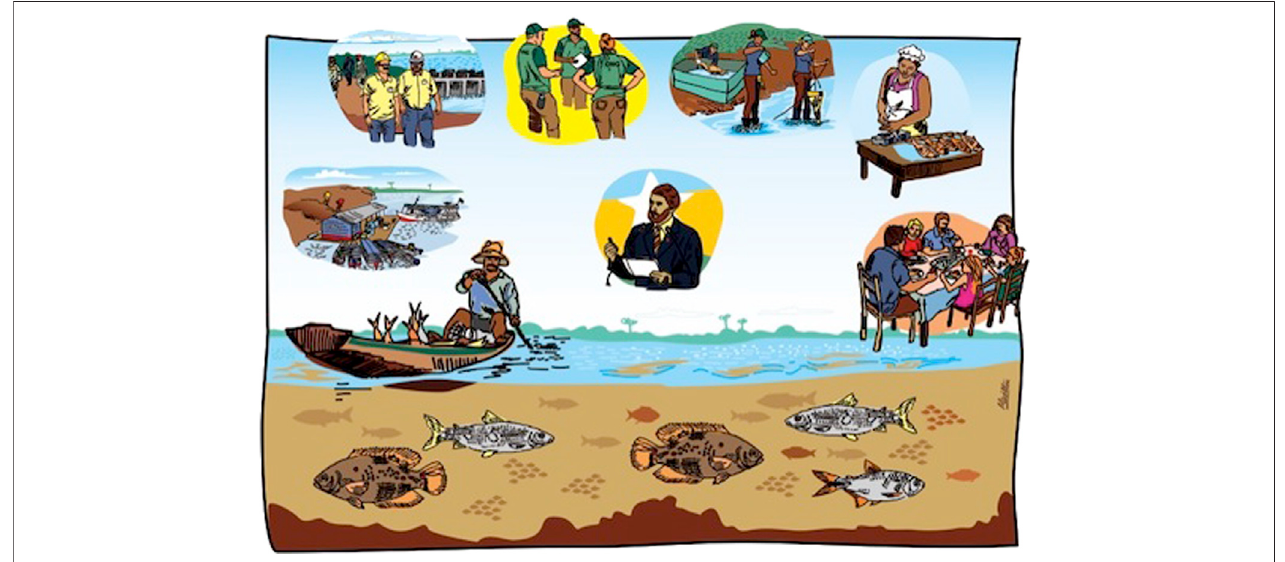
FIGURE 2 | Pictorial representation of the Madeira fi sheries system used in the stakeholders ’ interviews and cognitive maps. Each of the insert in the map correspondedtoacard,onthebottomthe fi shes,fromlefttoright,frombottomtotop:Fisher;Fisherscolonyorassociation;HydropowerCompany;Non-governmental organization; Science; Middlemen; Consumers and in the middle the